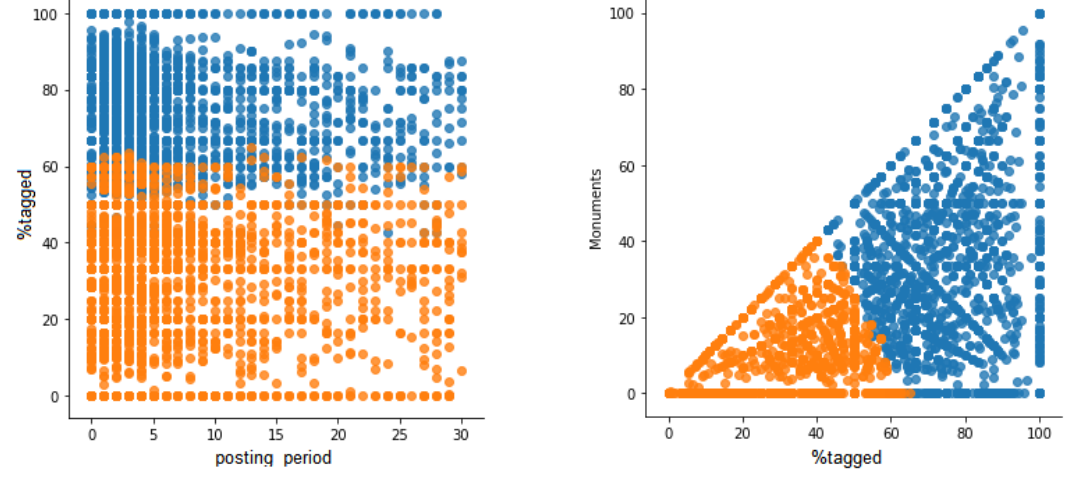
Figure 7. Classification of users according to clusters in